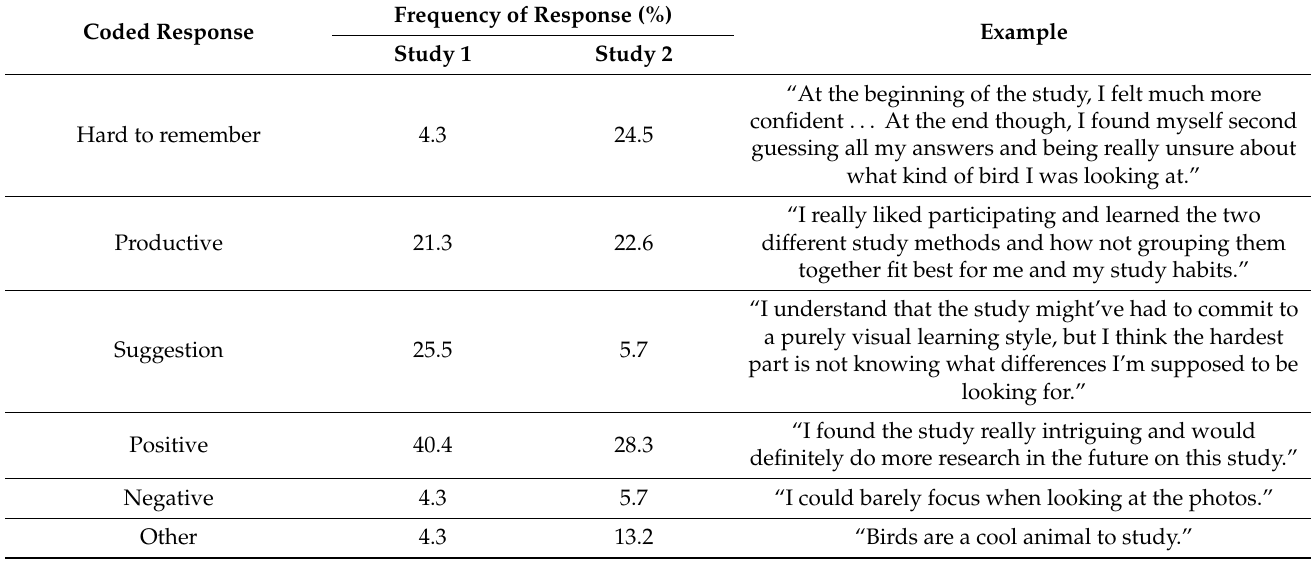
Table 2. Free-response feedback about